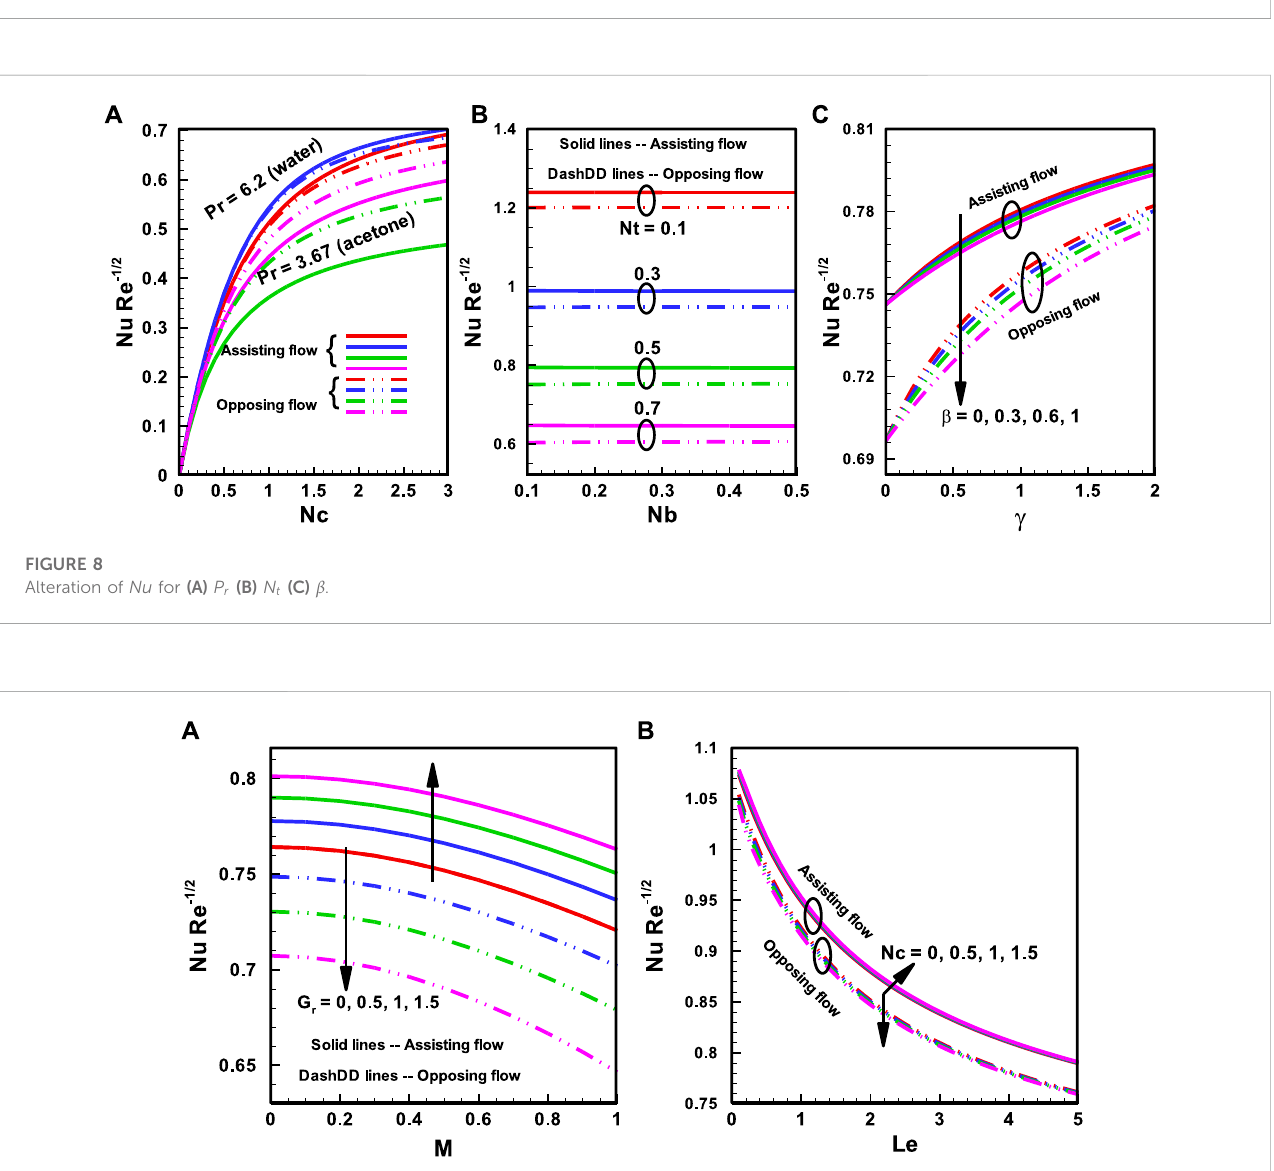
FIGURE 9 Nusselt number for (A) buoyancy in fl uence via Temperature Difference G r , (B) The ratio of Buoyancy forces on the rescaled concentration of nano-particles N c .